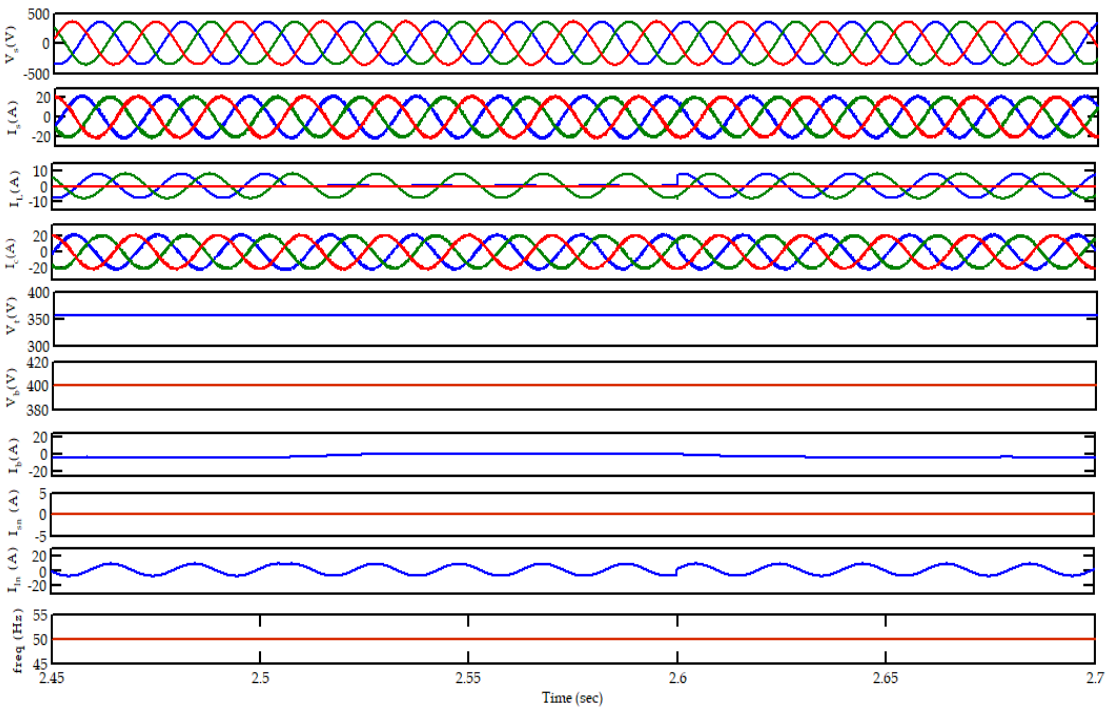
Figure 8. Performance of the Wind power unit with linear load at constant wind speed.